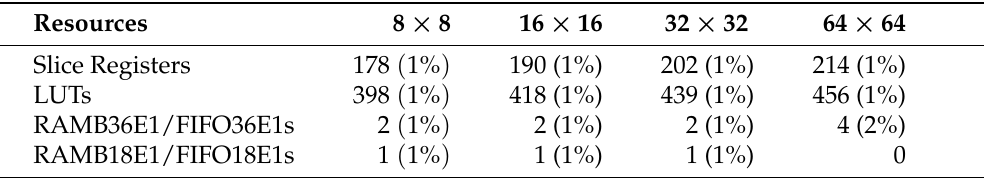
Table 4. Hardware resources of MEDCD for DoA